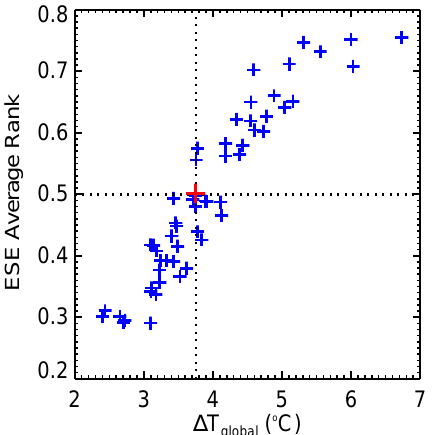
Fig. 2. The ESE members ranked by their A1B end-of-century tem- perature response and percentage precipitation change, averaged over the four seasons for 24 selected countries as a function of their 2080–2099 annual global temperature response with respect to 1961–1990. The exemplar member selected to show a represen- tative median response is marked in